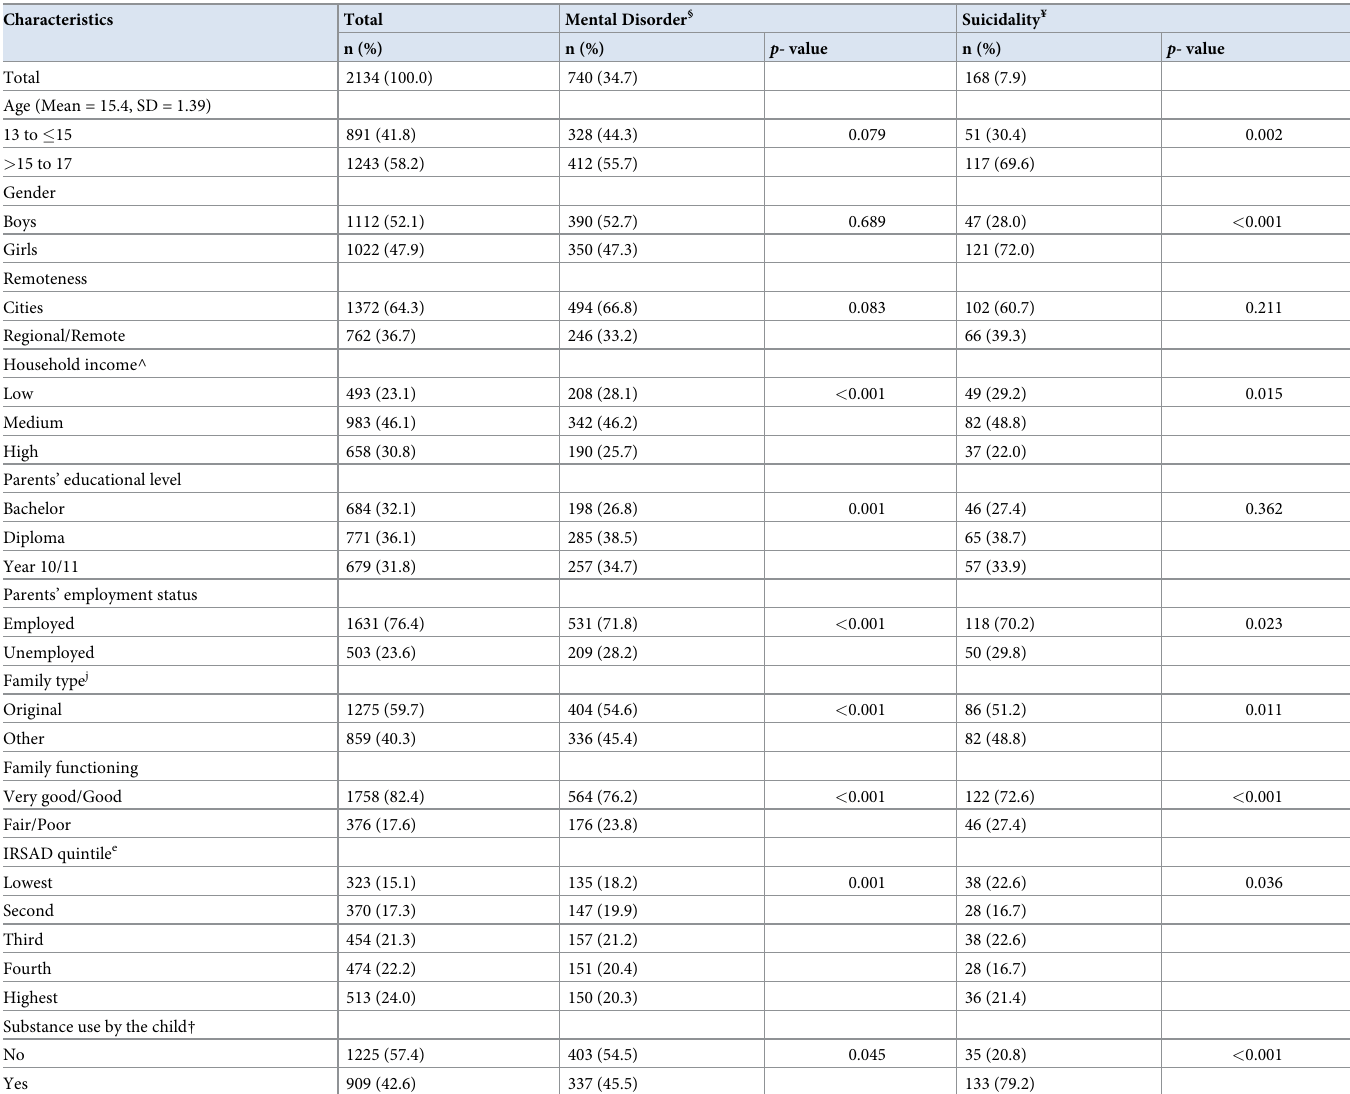
Table 1. Sample characteristics (i.e. Adolescents aged 13–17